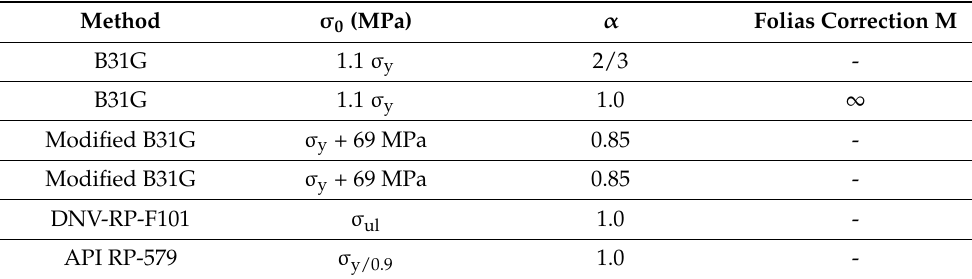
Table 7. Summary of limit pressure